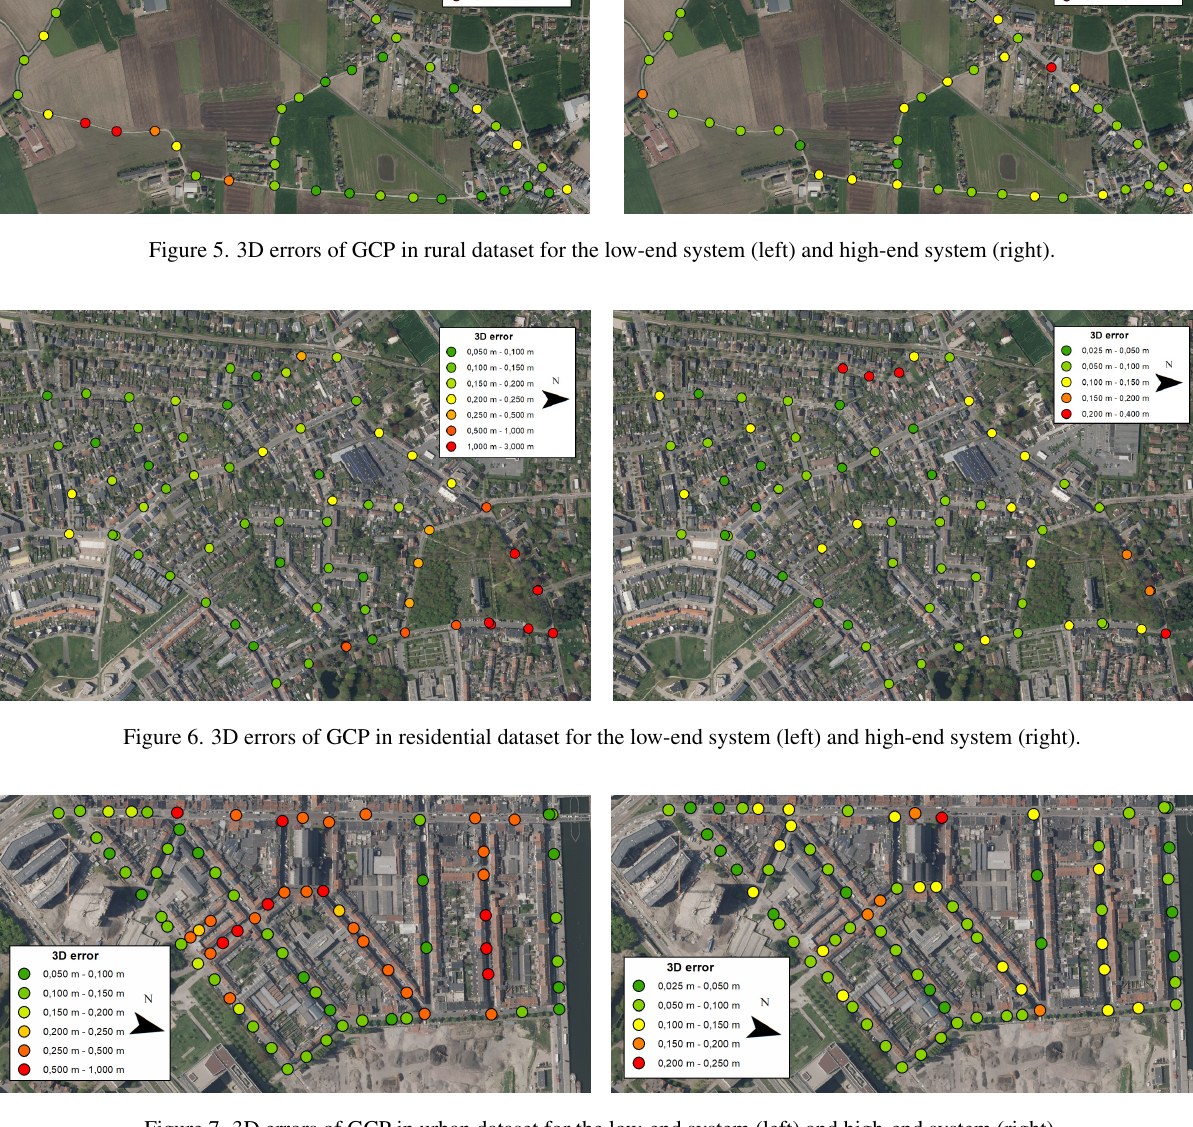
Figure 7. 3D errors of GCP in urban dataset for the low-end system (left) and high-end system